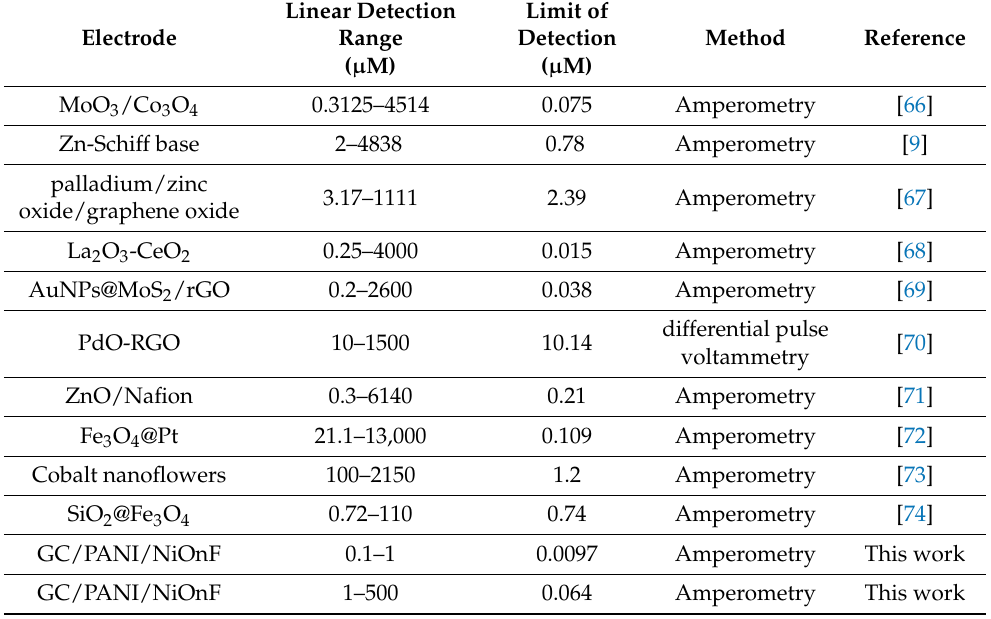
Table 3. Comparison between our results and other results reported in the literature for nitrite